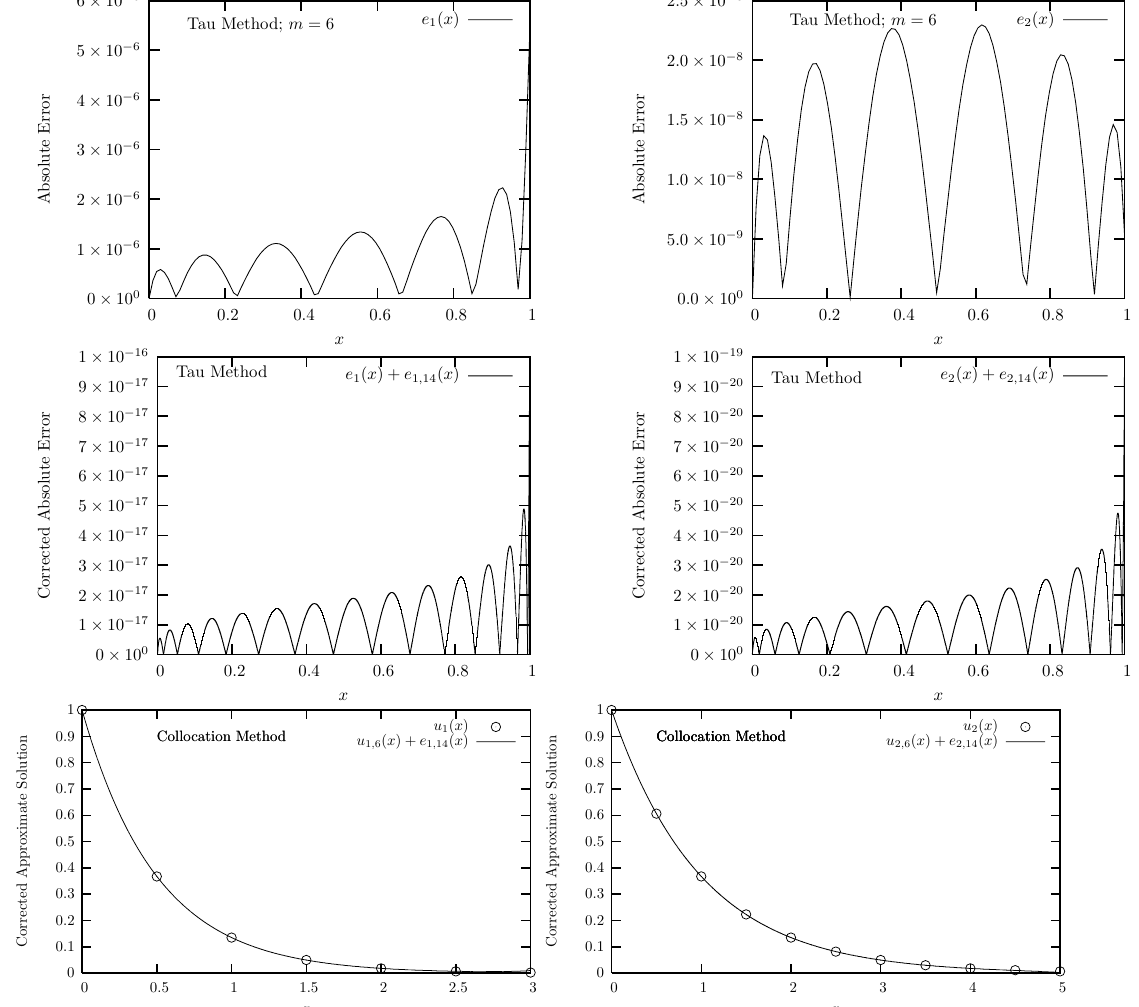
Figure 2. The absolute error, the corrected absolute error and corrected approximate solutions to Example 2 for m =